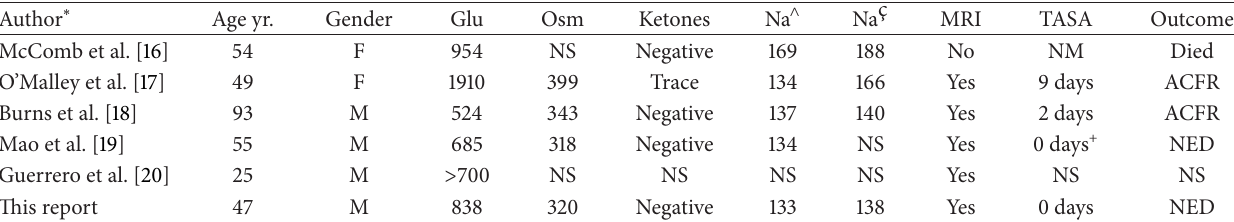
Figure 1: MRI with increased signal intensity on T2-weighted FLAIR images in the medulla oblongata and central pons (arrows). Table 2: Reported cases of CMP associated with